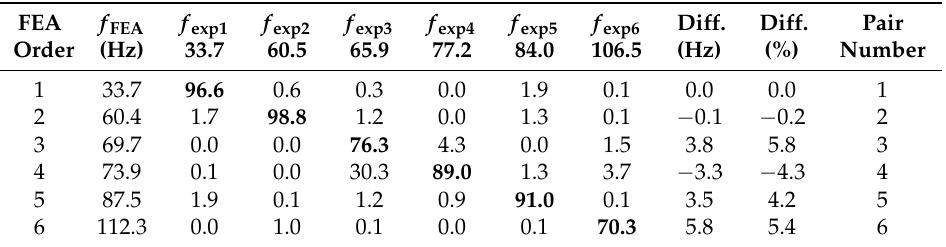
Table 4. Frequency differences and modal assurance criterion (MAC)